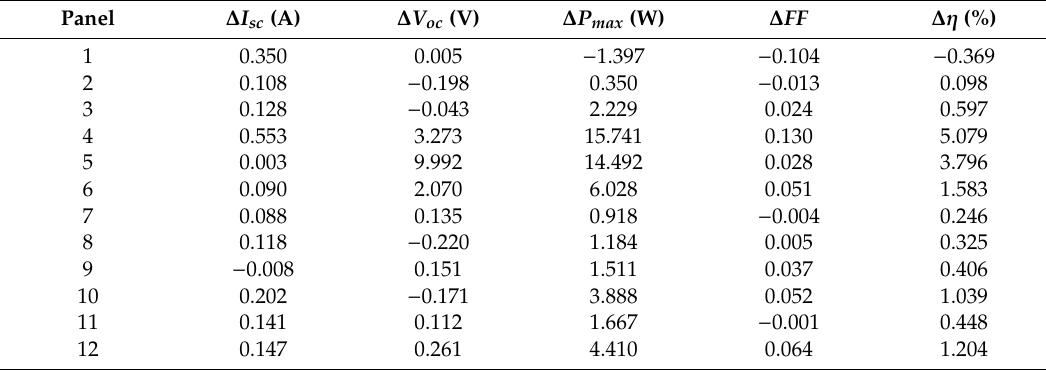
Table 3. Di ff erential values between simulation and measured results for the first test. Panel